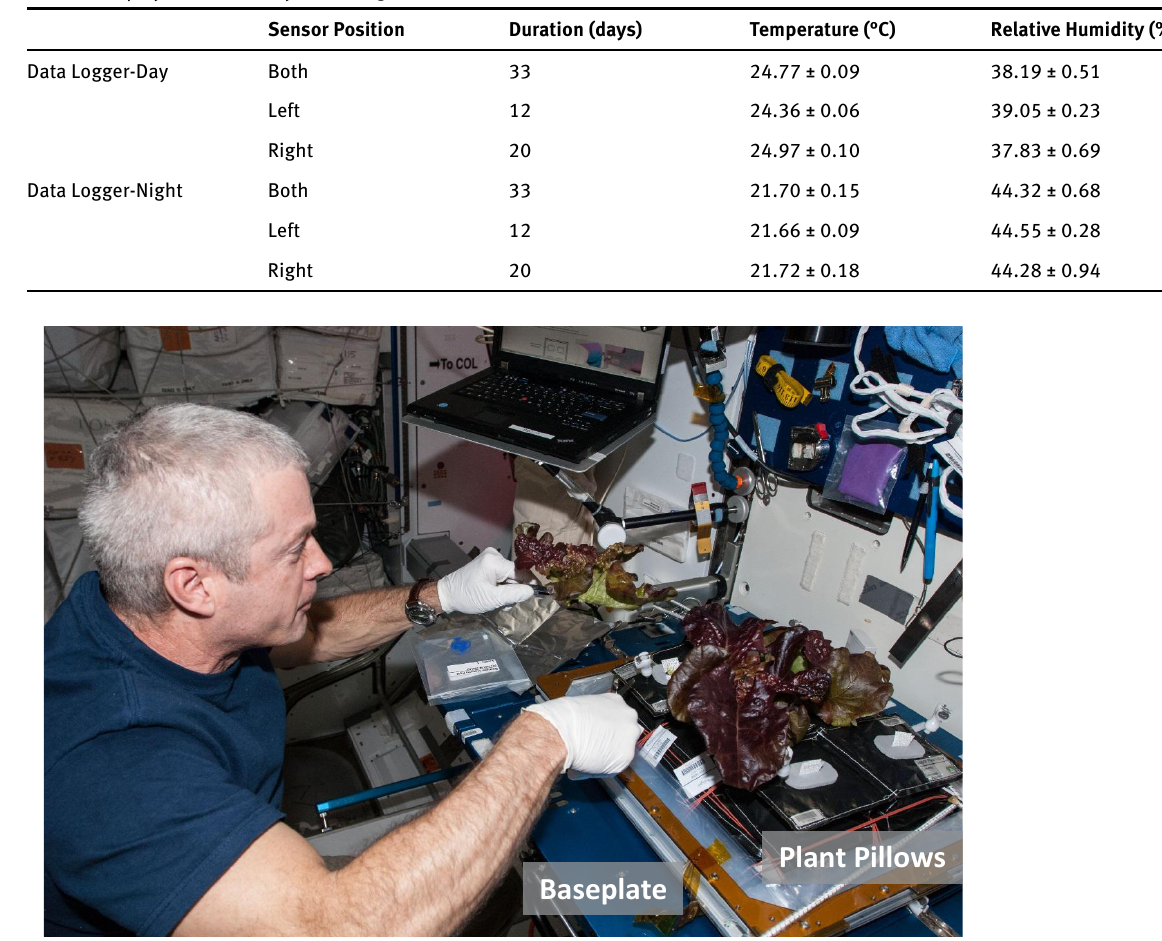
Figure 3. Astronaut Steve Swanson harvesting thirty three day-old Veggie-grown lettuce on the ISS on June 10,